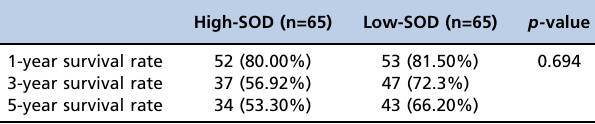
Table 4 - Survival rates of patients in the high- and low- superoxide dismutase